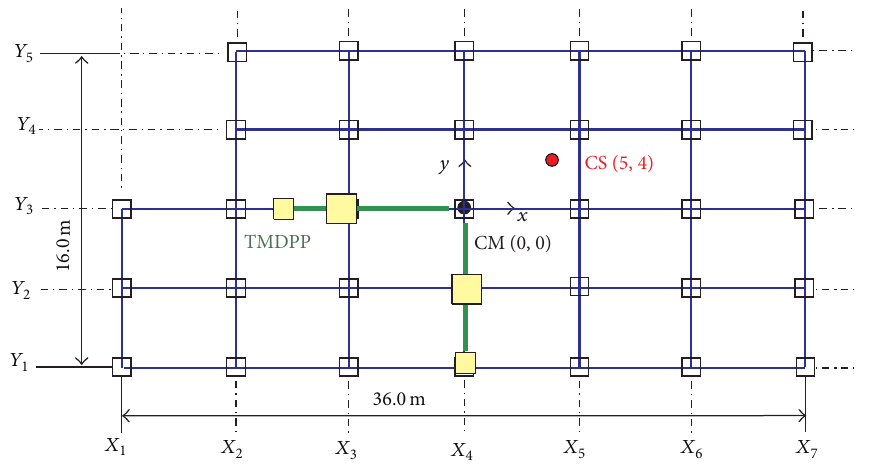
Figure 4: Arrangement position and scheme of TMDPP.